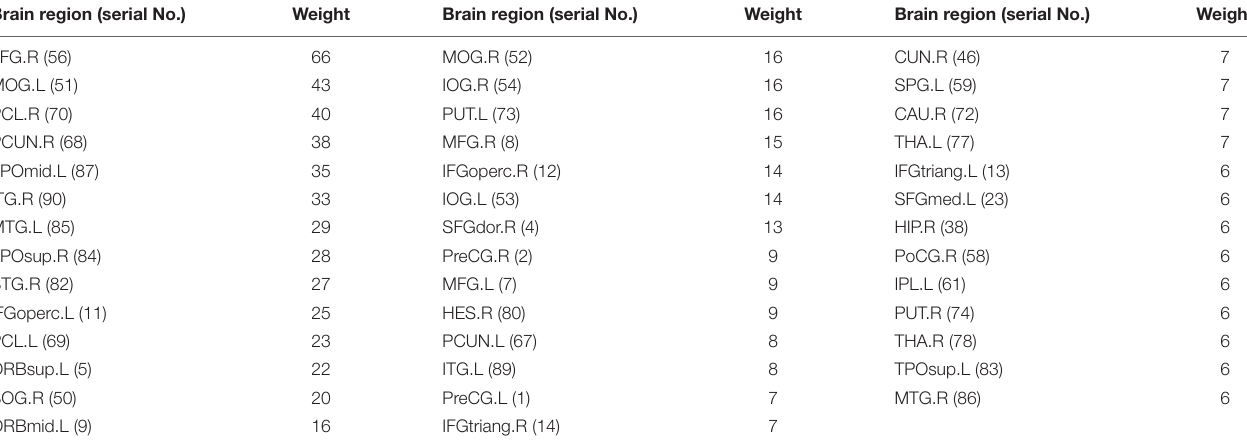
TABLE 5 | The brain regions corresponding to the key features with weight greater than or equal to 6. Brain region (serial